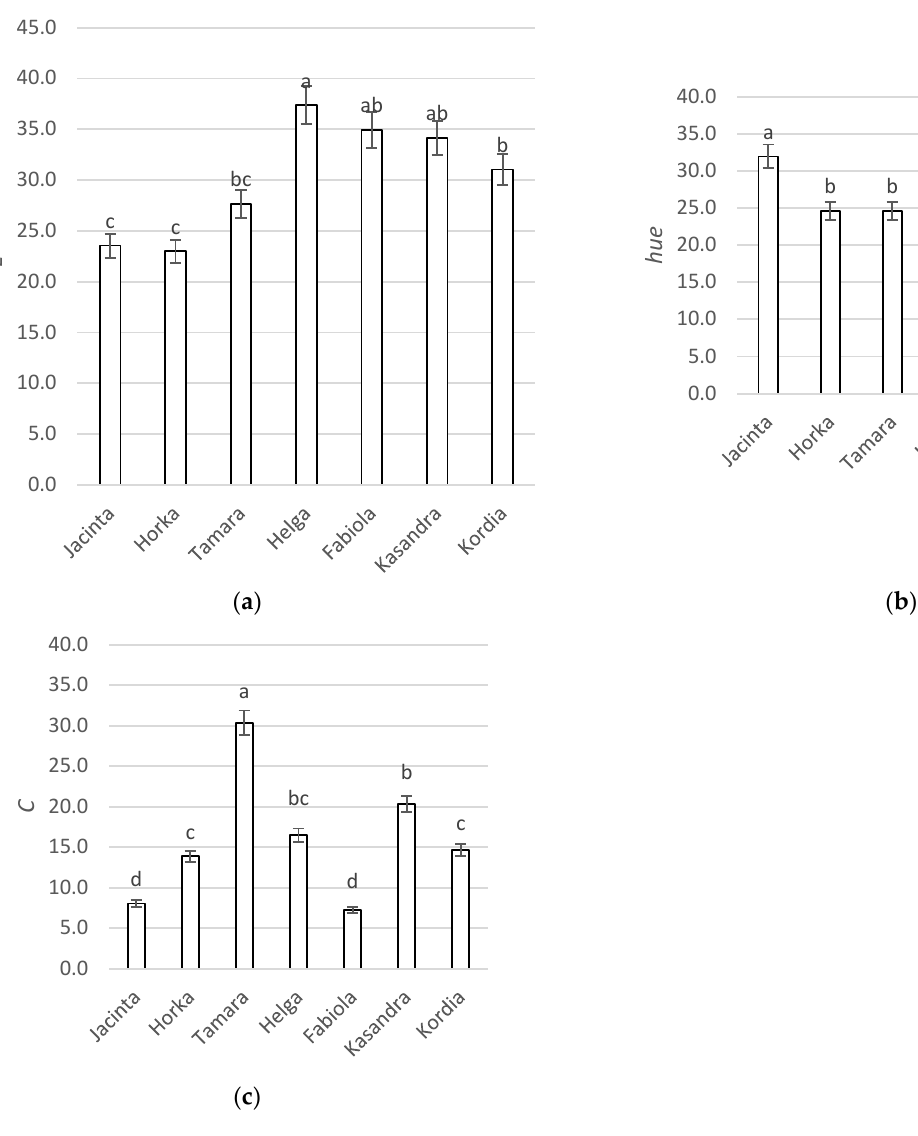
Figure 1. External color of fruit: ( a ) L* , ( b ) hue and ( c ) chroma ( C ), depending on the cultivar. Values with different letters are significantly different.